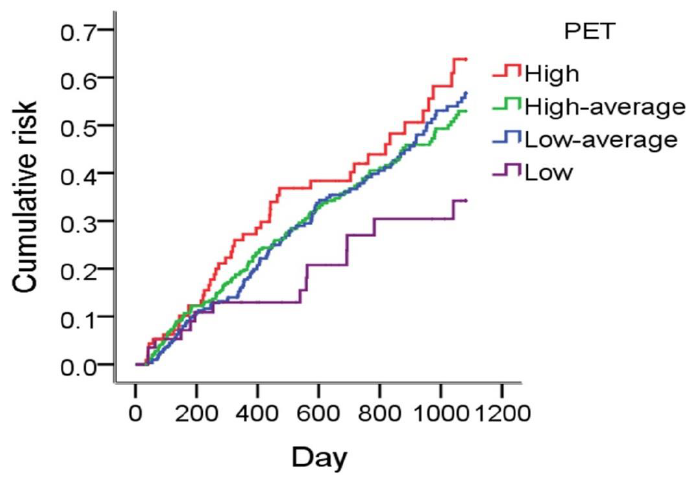
Figure 2. Peritonitis rates in different peritoneal transport groups. Table 2. Uni-and multivariate Cox regression analysis of the peritonitis risk factor.